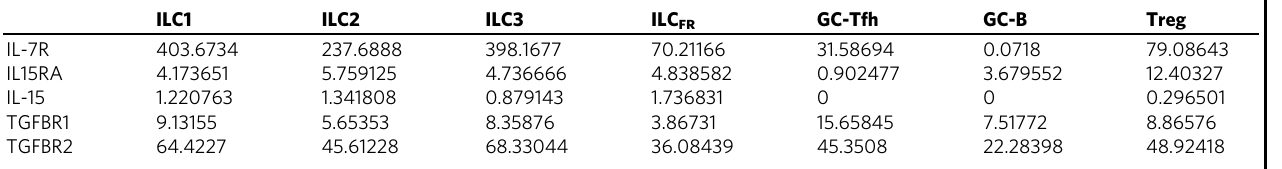
Table 1 Cytokine Receptor expression on sorted human tonsillar cell